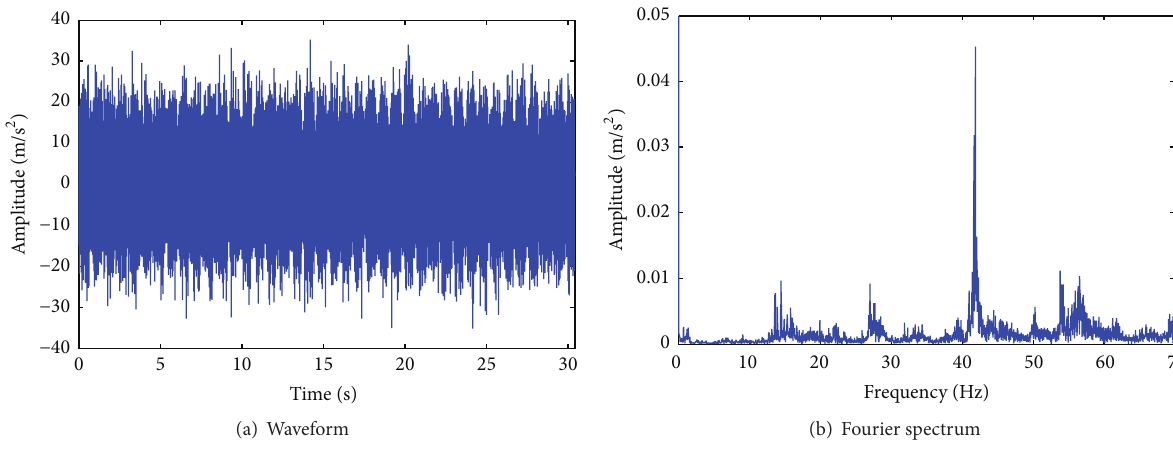
Figure 13: Faulty